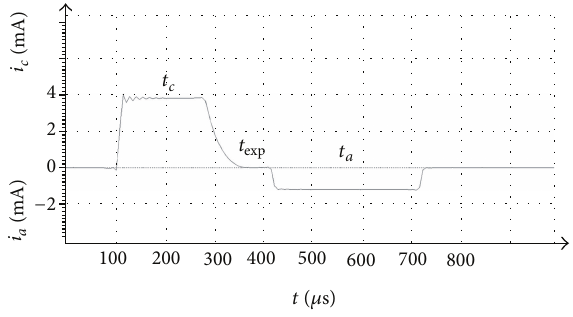
Figure 2: Parameters and waveform of the stimulus determined in the